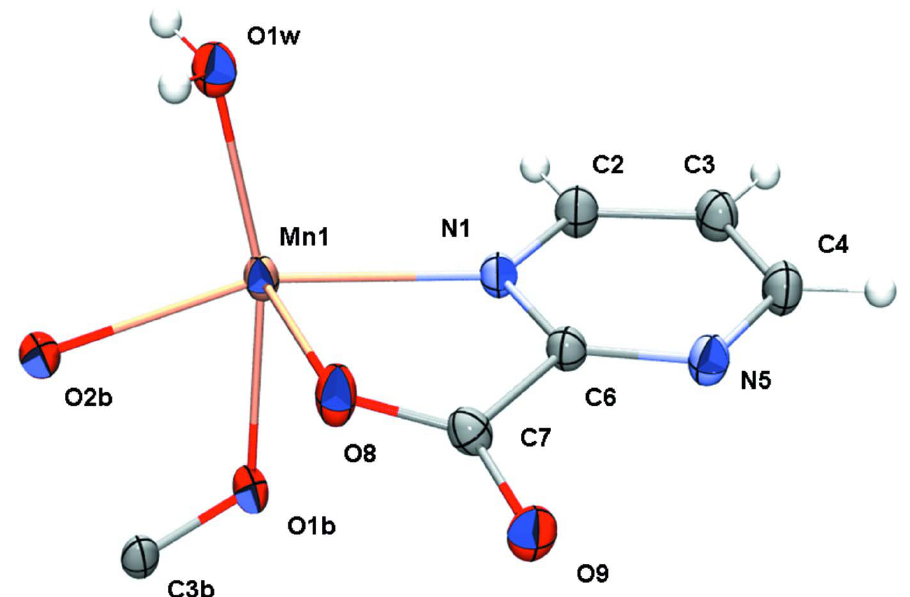
Figure 1 The molecular structure of the asymmetric unit of [Mn ellipsoids are drawn at the 50% probability level. H atoms are represented as spheres of arbitrary radii.